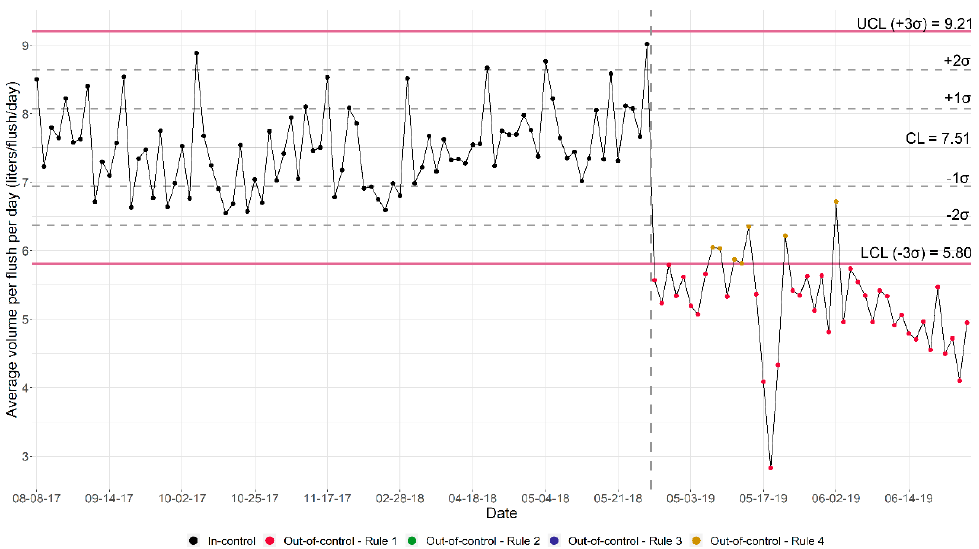
Figure 5. Shewhart Control Chart—Average volume per flush per day.